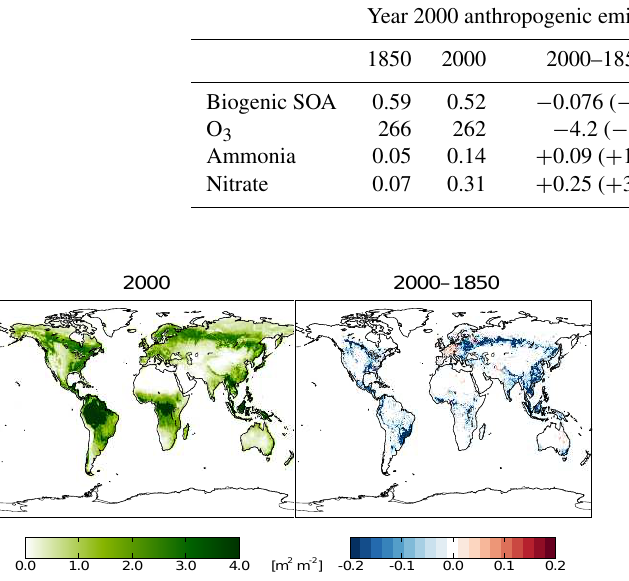
Figure 3. Annual average leaf area index (LAI) in present day (left) and the change in LAI from preindustrial (1850) to present day (2000) (right).